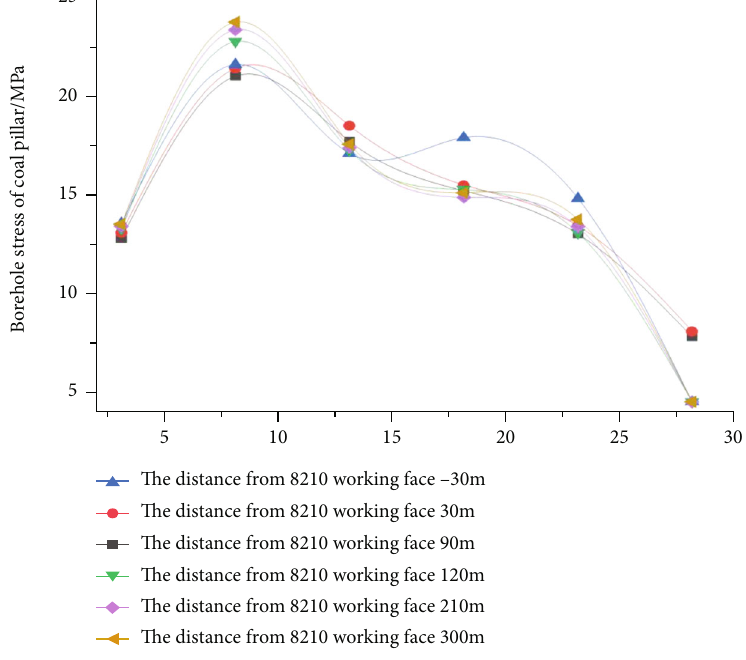
Figure 12: Dynamic evolution of bearing stress in the coal